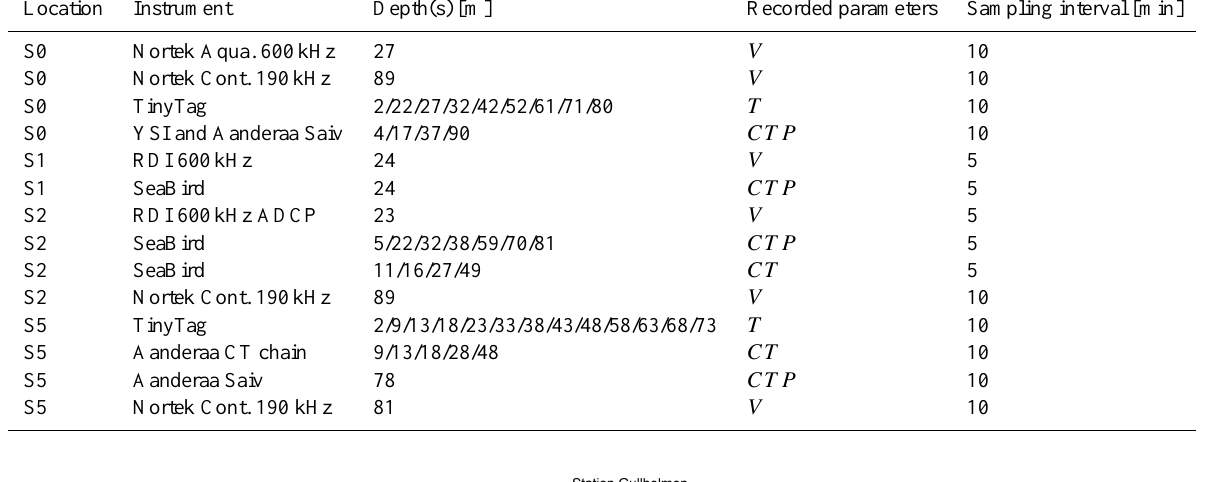
Table 1. Instrumental set-up at the moorings. The parameters are C =conductivity, T =temperature, P =pressure, V =velocity.